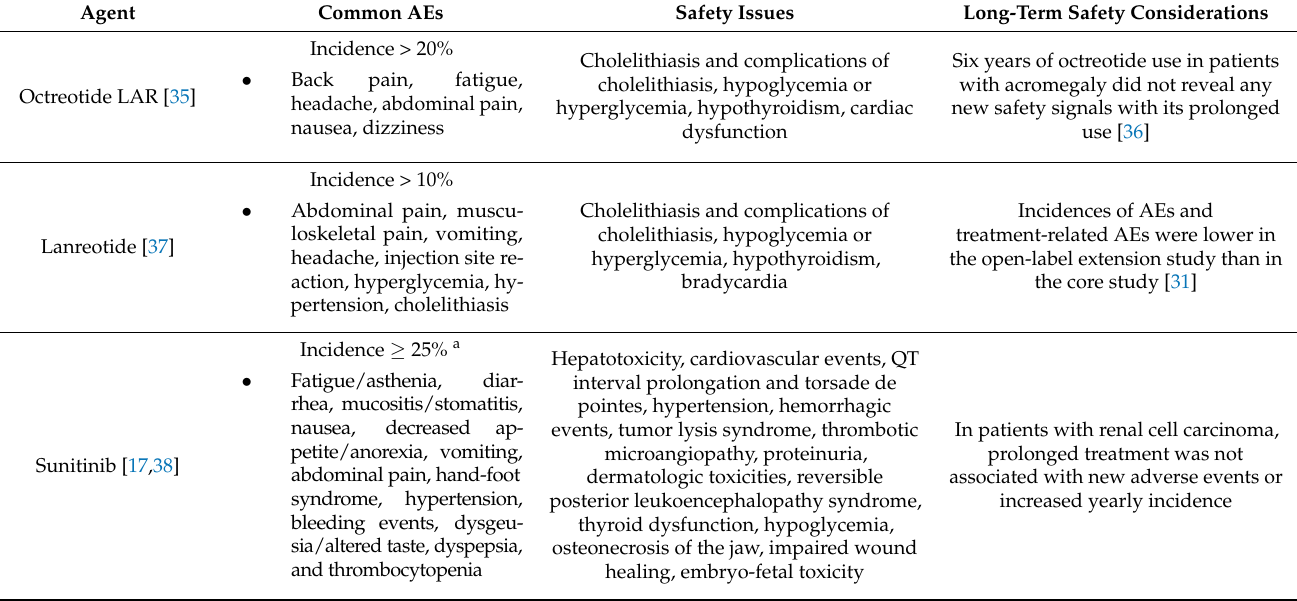
Table 2. Tolerability, safety, and monitoring issues of therapeutics for advanced